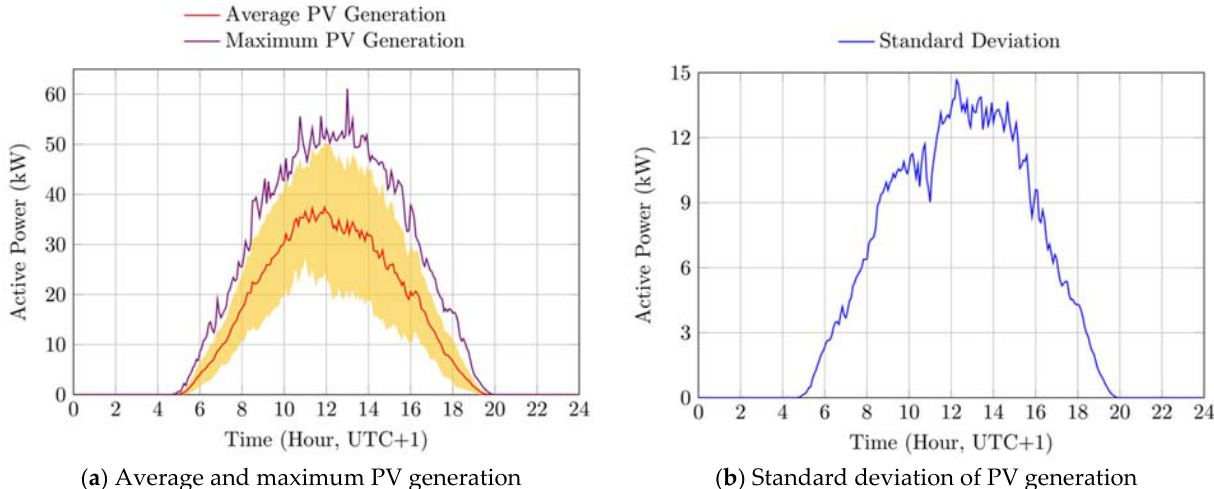
Figure 3. Active power generation profiles of the PV system during May 2020. In sub ‐ figure ( a ), the red area represents the standard deviation of the measurements for each 𝑖 ‐ th time interval, which is reported in detail in sub ‐ figure ( b ). UTC: universal time coordinated.